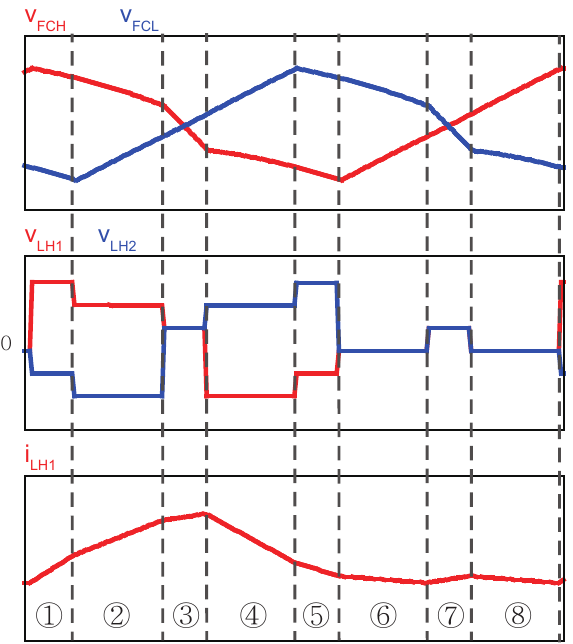
Figure 13. Voltage and current waveforms for Z-type interleaving with an open loop